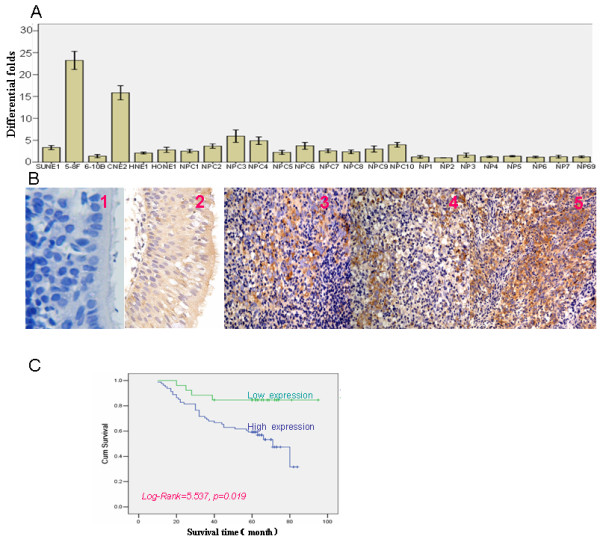
The increased expression levels of EIF4G1 mRNA and protein in NPC tumor tissue and cell lines and their association with the overall survival of NPC patients. A. EIF4G1 mRNA expression in NPC cell lines, tumor tissues, and non-cancerous nasopharyngeal (NP) tissues. EIF4G1 mRNA level was relatively high in NPC tissue, NPC cell lines (except 6-10B cells) comparing to nasopharyngeal tissue and NP69 cells. B. EIF4G1 protein expression in NPC and nasopharyngeal tissues.(1) Negative control; (2) Weak expression of EIF4G1 in nasopharyngeal tissues; (3-5) Strong expression of EIF4G1 in NPC tissues (magnification 400×). C. Kaplan--Meier survival analysis of the overall survival time in 107 NPC patients based on the levels of EIF4G1 protein expression. The log-rank test was used.